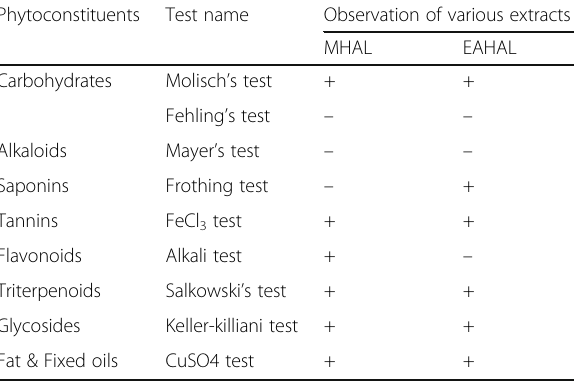
Table 1 Phytochemical screening of MHAL and EAHAL Phytoconstituents